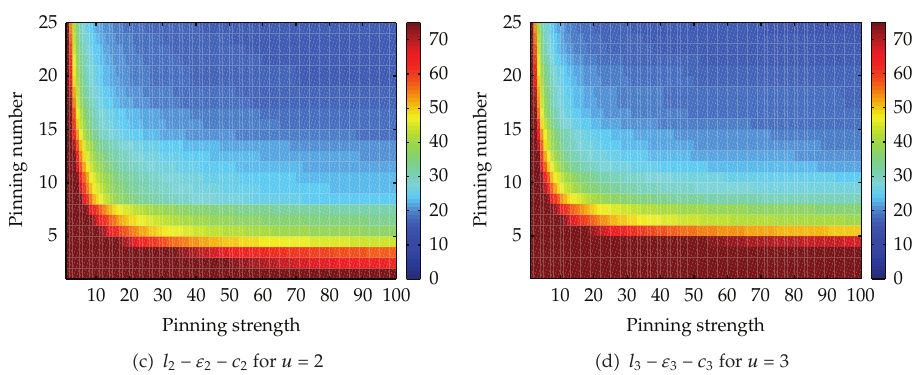
Figure 10: (cid:6) Color and style online (cid:7) l u − ε u − c u expresses the critical combination of the coupling strength, the number of pinned nodes, and the control strength of the u th cluster. (cid:6) b (cid:7) The relationship between ε , l and c of the first cluster. (cid:6) c (cid:7) The second cluster. (cid:6) d (cid:7) The third